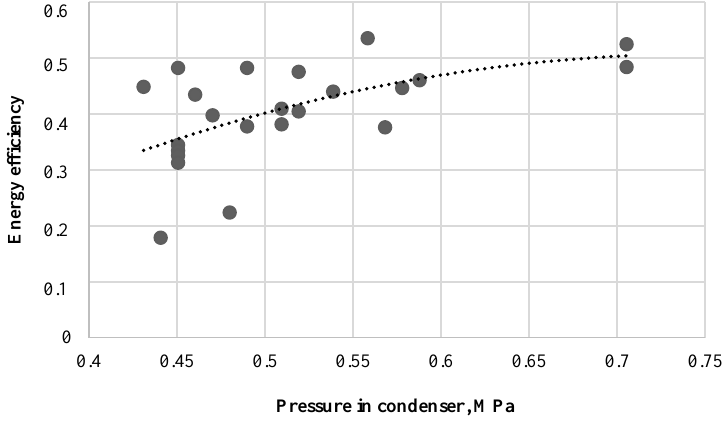
Fig. 7. Two-stage compressor refrigeration system exergy efficiency depending on ambient temperature and evaporator temperature difference. Fig. 7 shows information on two-stage changes in the compressor refrigeration system’s exergy efficiency depending on the pressure in the condenser. From the information presented, it can be concluded that the exergy efficiency increases with increasing pressure in the condenser. Exergy efficiency reaches a maximum value of 0.54 at a pressure of 0.56 MPa in the condenser. The increase in pressure in the condenser can be explained by the increase in the water temperature of the condenser cooling. The condenser cooling water temperature reaches its maximum value in the warmer months of the year. Conversely, the low correlation between the efficiency of the exergy of the refrigeration system and the pressure in the condenser can be explained by the fact that other parameters, such as the ambient temperature, also affect the efficiency of exergy.